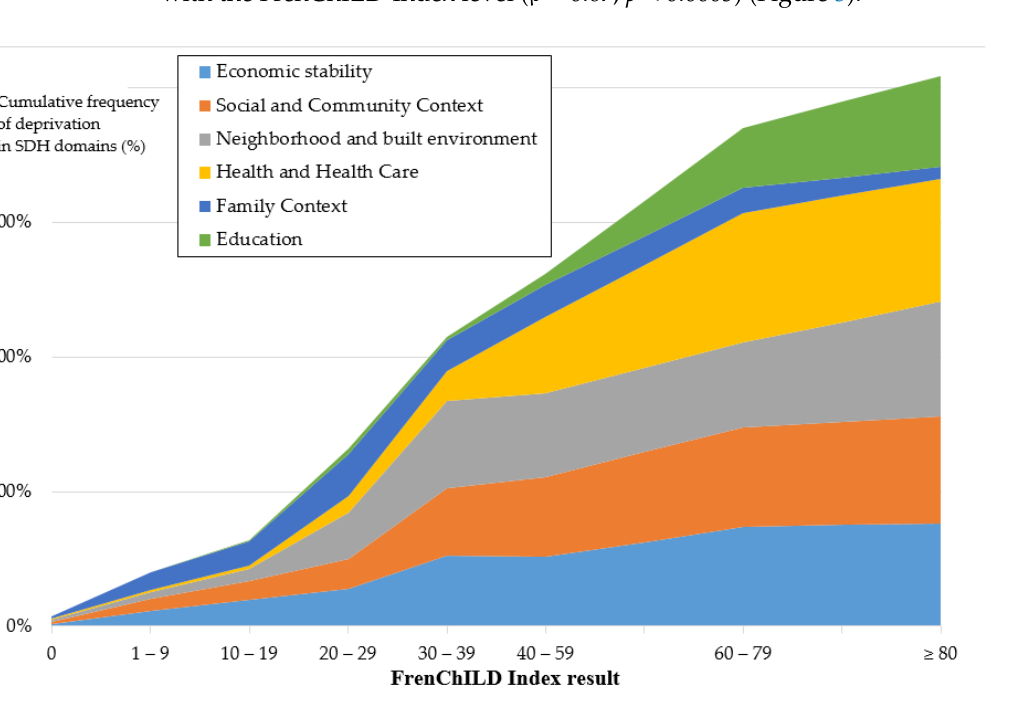
Figure 3. Piling up of the cumulative frequency of deprivation in the social determinants of health (SDH) domains by French Child Individual-Level Deprivation Index (FrenChILD-Index) level.